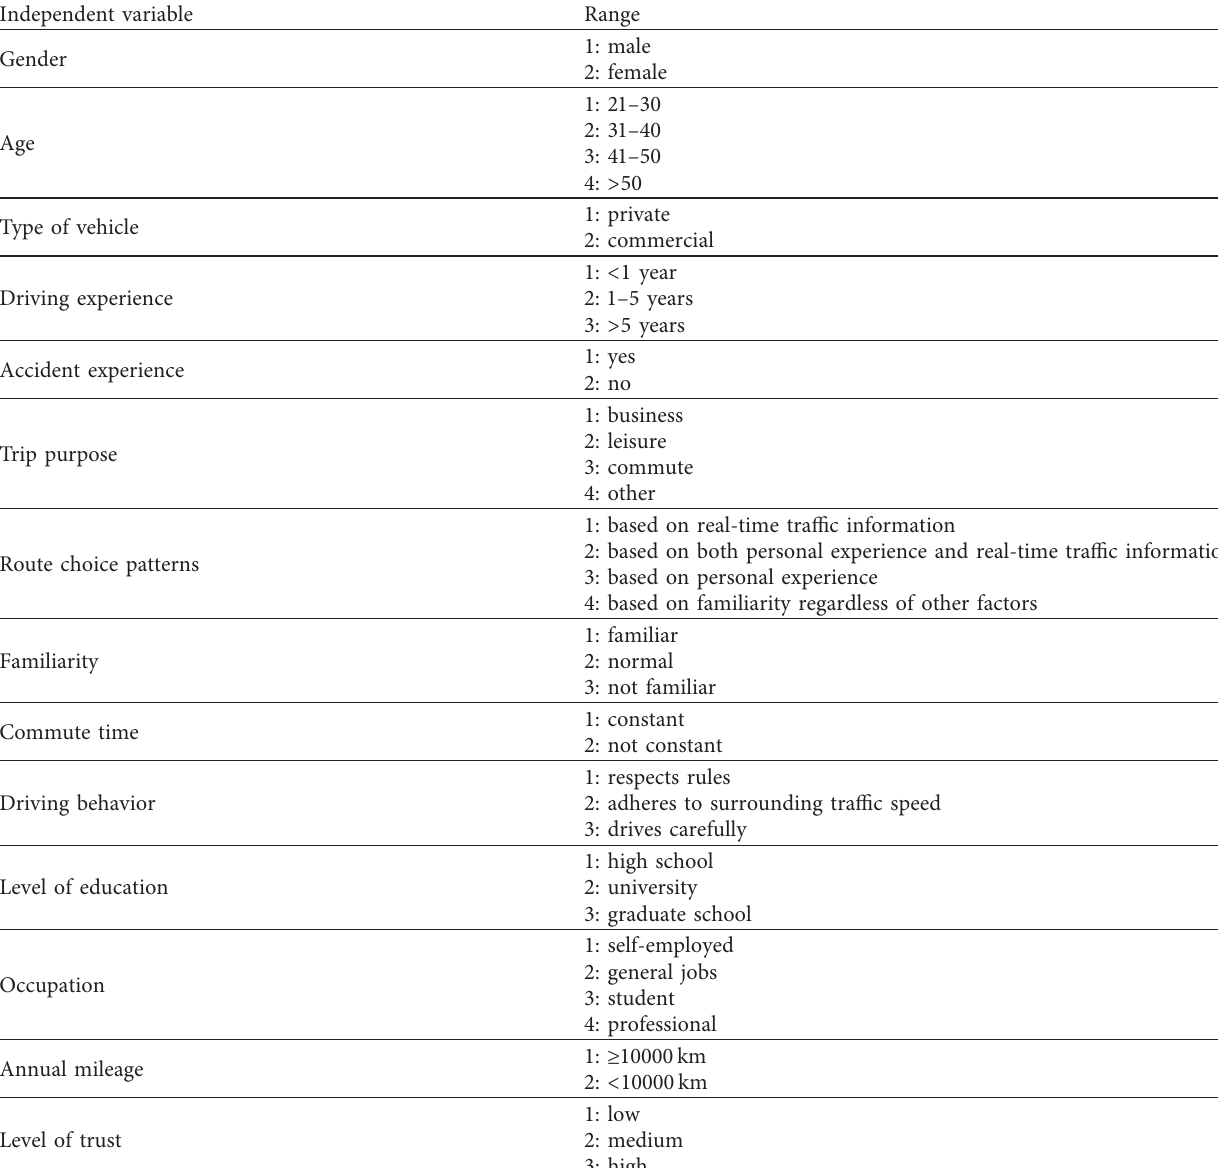
Table 2: Values of variables used in the ordinal